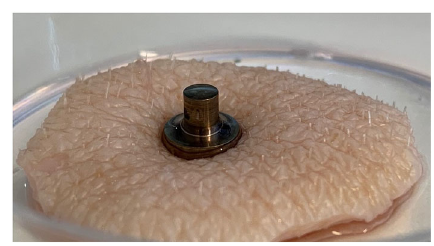
Fig. 3 Photograph of an implant inserted in